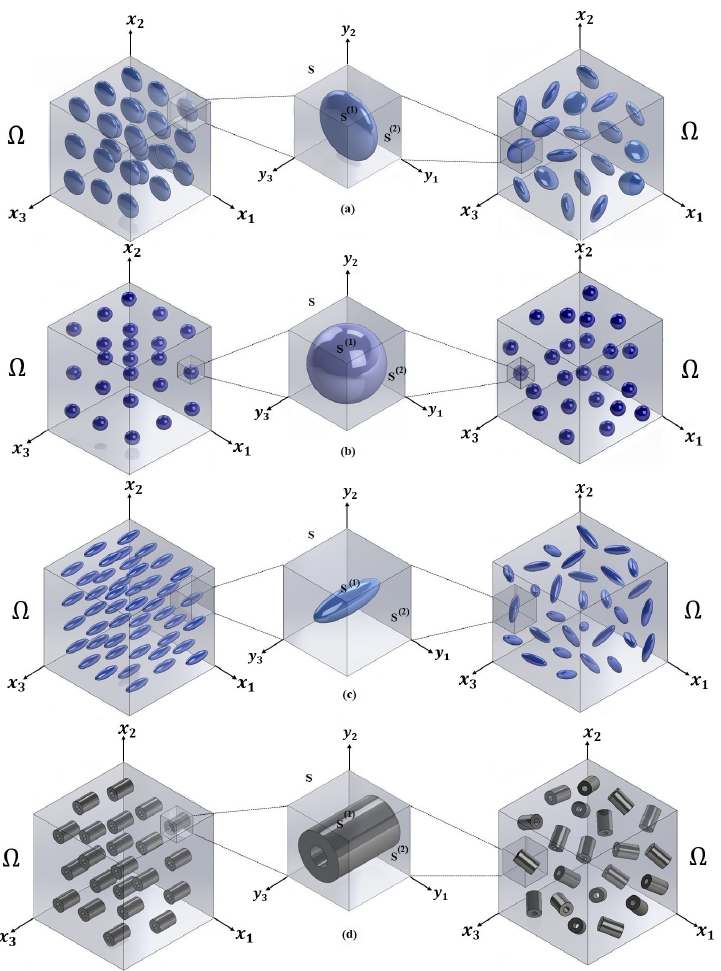
Figure 1. Representative section of a two-phase composite material reinforced by aligned (left) and random (right) inclusions. Three-dimensional periodic cell (middle) with different inclusion shapes: discs ( a ), spheres ( b ), ellipsoids ( c ) and hollow cylinders ( d